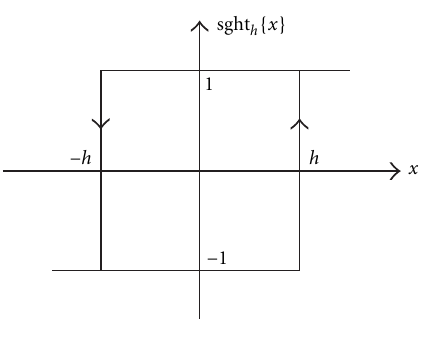
Figure 2: The hysteretic decision function.